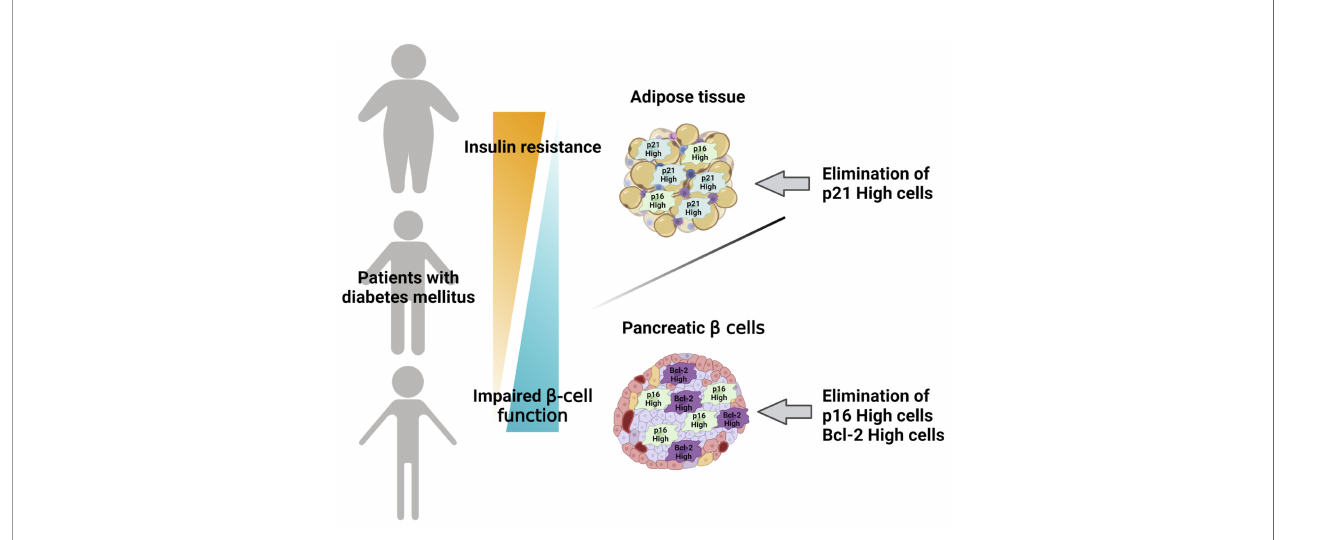
FIGURE 4 | Dual-targeted approach in senotherapy for diabetes. A tailored strategy targeting adipose tissue and/or pancreatic b cells is proposed for senotherapy against diabetes. Distinctive senescence markers of adipose tissue and/or pancreatic b cells are targeted based on individual pathophysiological conditions of diabetes. Created with